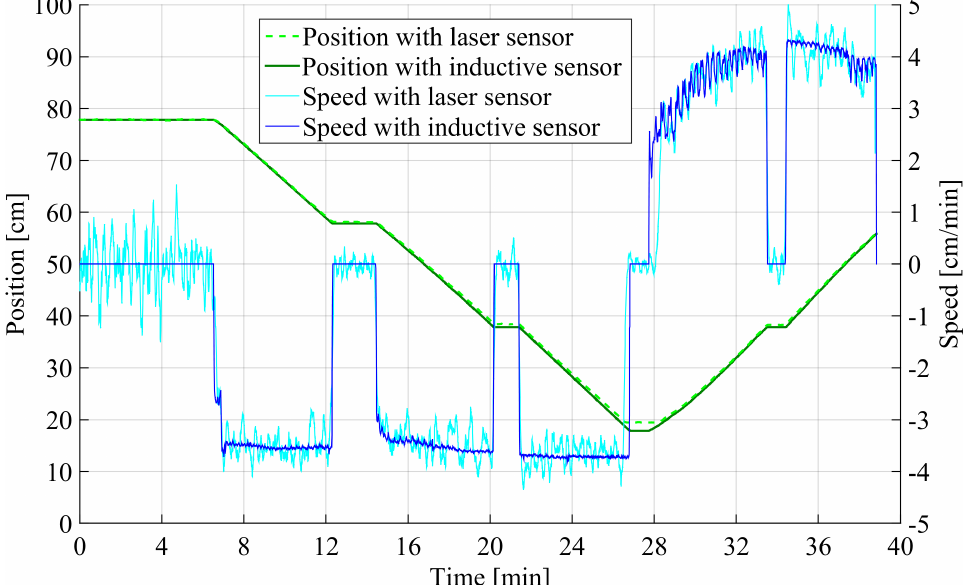
Figure 12. The position and the speed of the screw calculated from the inductive and laser sensor